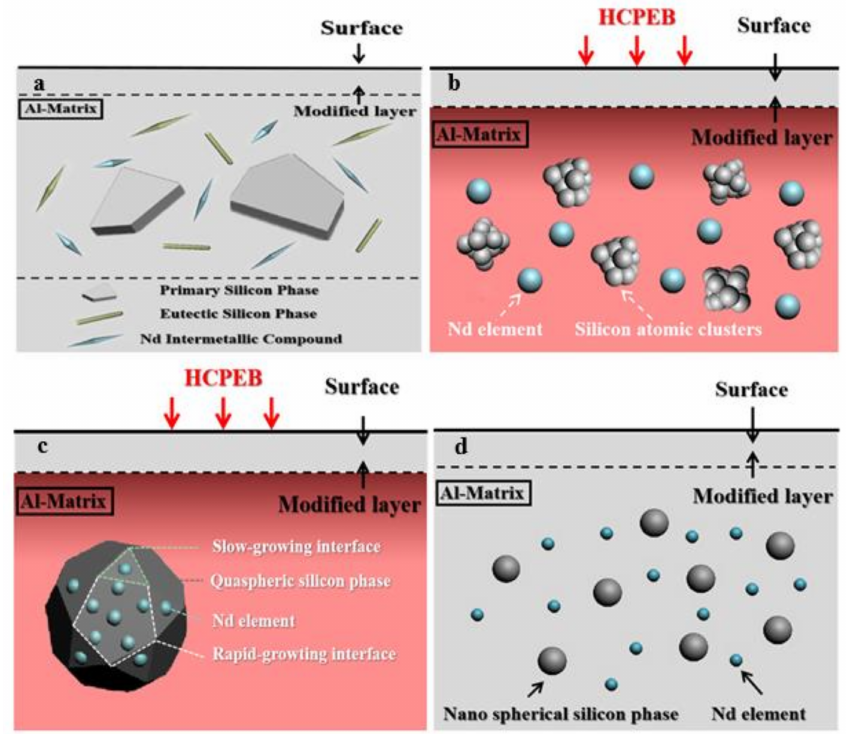
Figure 4. Schematic diagram of the spheroidization mechanism of the primary silicon phase induced by Nd under the HCPEB irradiation. ( a ) The initial stage; ( b ) The melting stage; ( c ) The spheroidizing stage; ( d ) The final